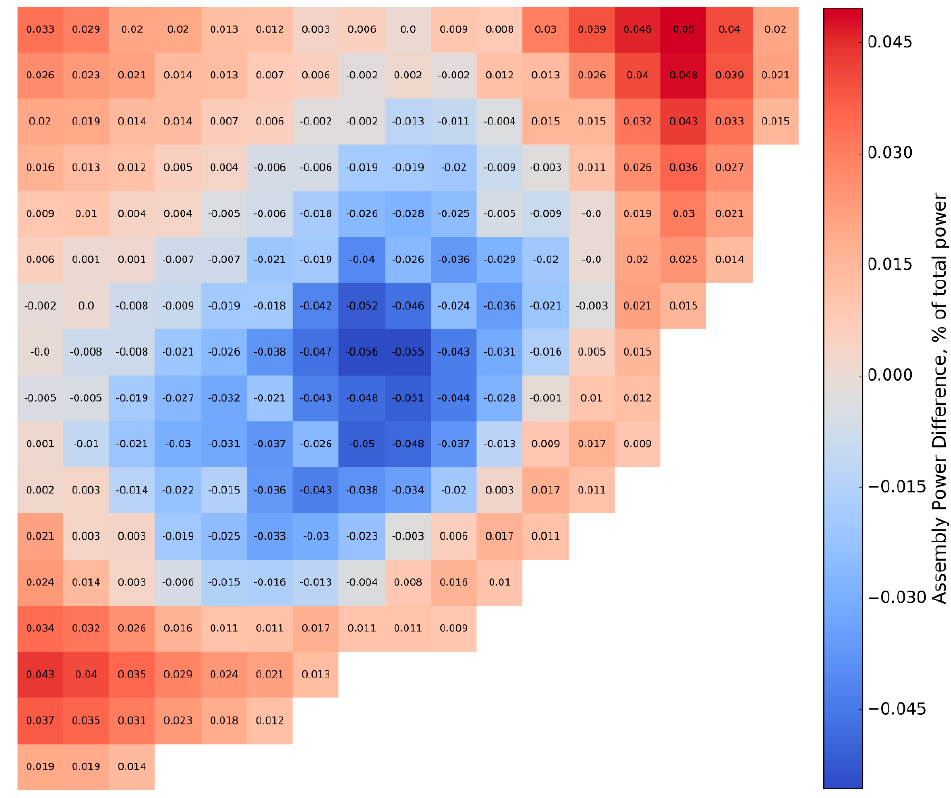
Figure 26. Purely neutronic assembly power difference (Serpent—DYN3D) between Serpent and CTF with relation to the % of the total power.